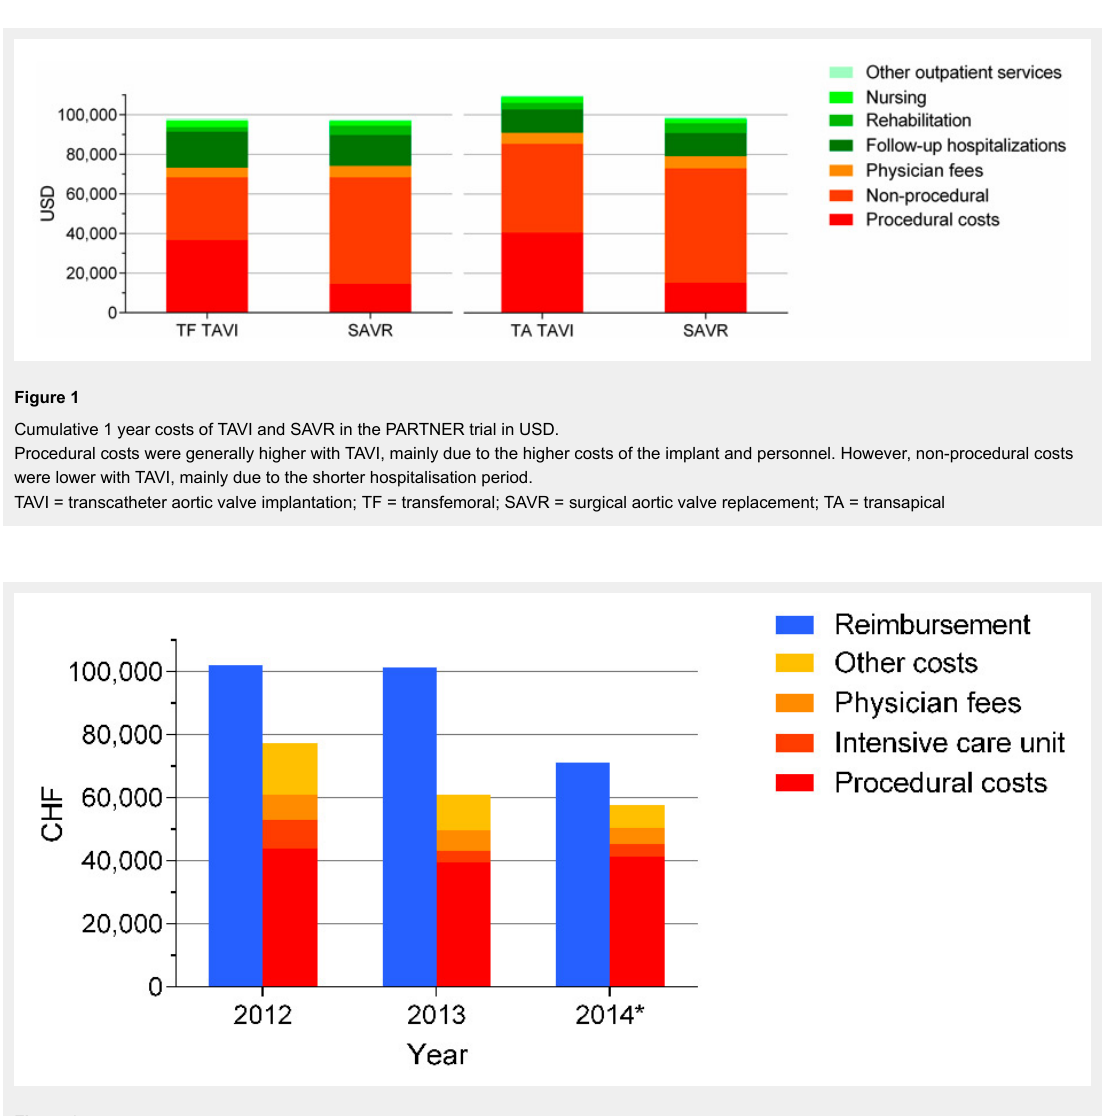
Reimbursement and costs of TAVI in Switzerland 2012–2014. The case weight for TAVI in Switzerland was 9,707 in 2012, 9,795 in 2013, and decreased to 7,159 in 2014. The case weight will further decrease to 6,216 in 2015. Between 2012 and 2014, costs for intensive care unit, nursing, physiotherapy, and other costs were reduced, but procedural costs including costs for the implant remained relatively unchanged (example of the Cantonal Hospital Lucerne). Median hospital stay decreased from 9 days (2012) to 7 days (2014). *January – June